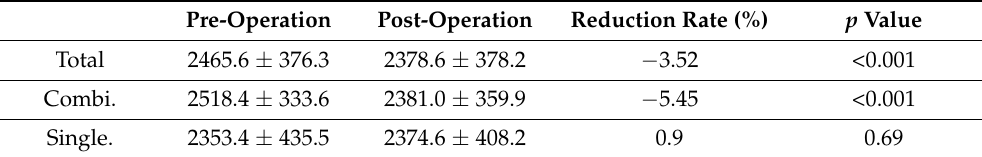
Table 3. Changes of Corneal endothelial cell